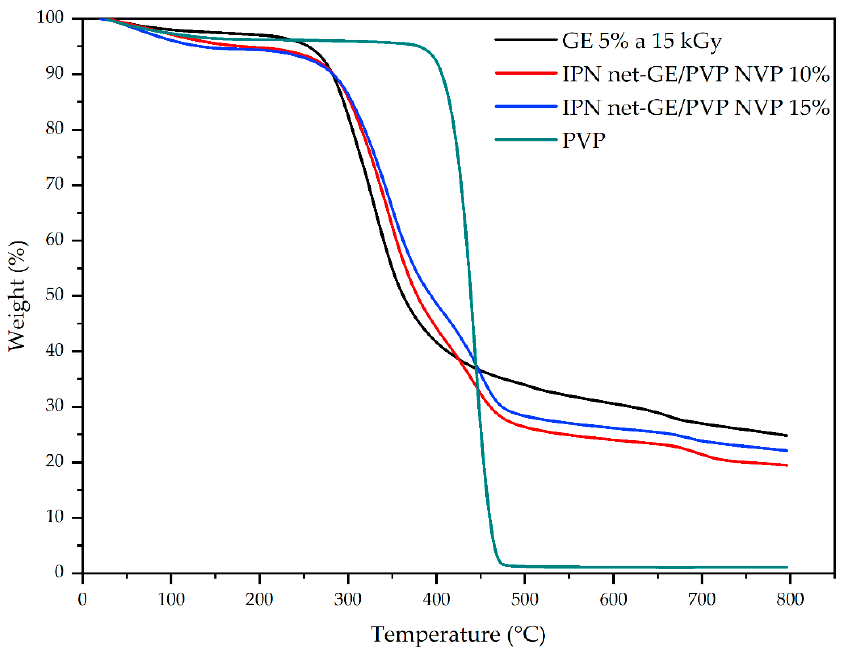
Figure 3. TGA thermograms under N 2 of net -GE, PVP, and IPN net -GE/PVP.